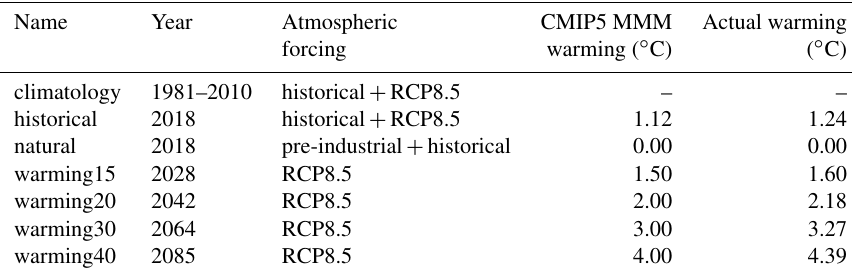
Table 1. Overview of